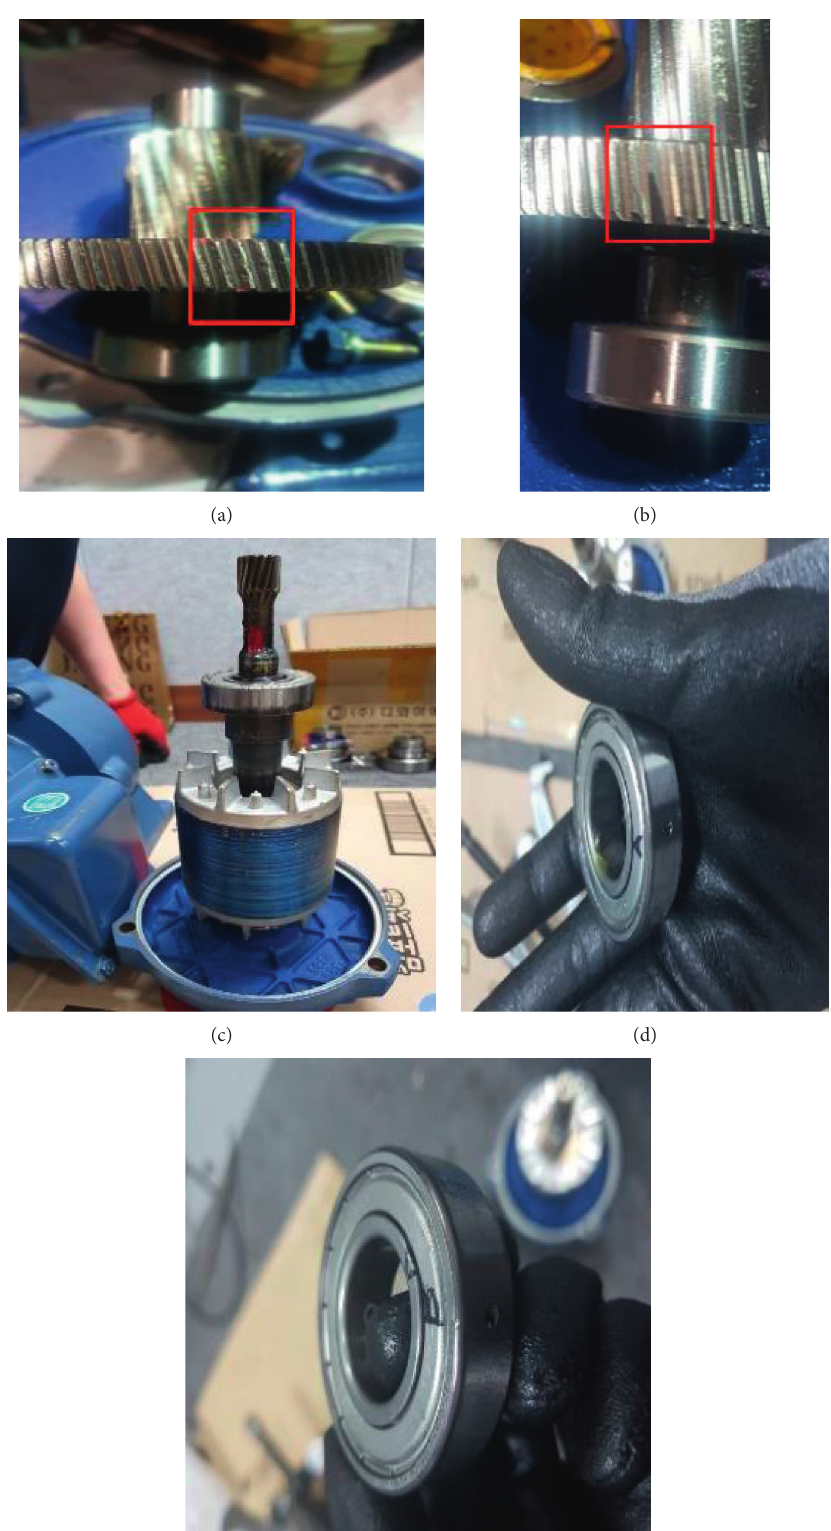
Figure 3: Examples of different bearings and gear conditions and unbalanced shaft of the electric motor: (a) cracked gear tooth, (b) broken gear tooth, (c) unbalanced motor shaft, (d) outer-raceway fault by making hole, and (e) inner-raceway fault by inserting matter through the